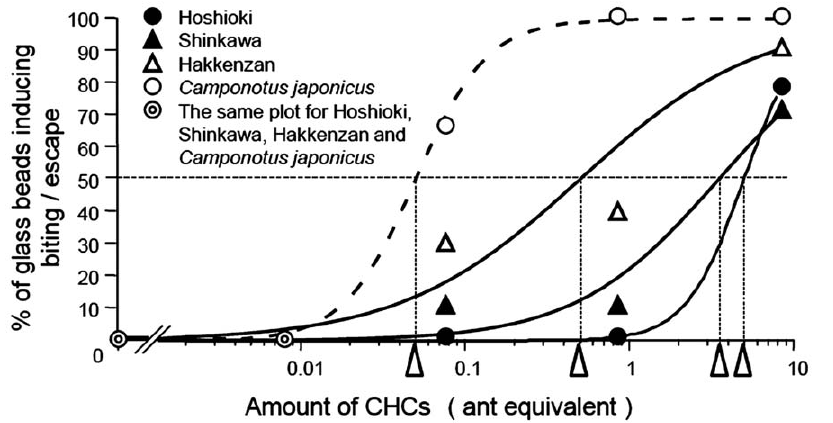
Figure 6. Dose-dependent aggressive response to CHCs. Percentage of discriminator ‘‘Hoshioki’’ workers that bit at the CHC-coating glass beads as surrogate ants are plotted against the ant equivalent amount of CHCs (total amount of components) derived from ‘‘Hoshioki’’, ‘‘Shinkawa’’, Hakkenzan’’, and C. japonicus workers. The fitting curves were drawn by Igor pro ver.4.0, under the hypothesis that all the discriminators could show biting behavior toward infinitely large amounts of CHCs, regardless of their nests. The CHC amounts giving half the maximum response, which is defined as the mean threshold amounts of CHCs for inducing biting behavior, are indicated by arrowheads.